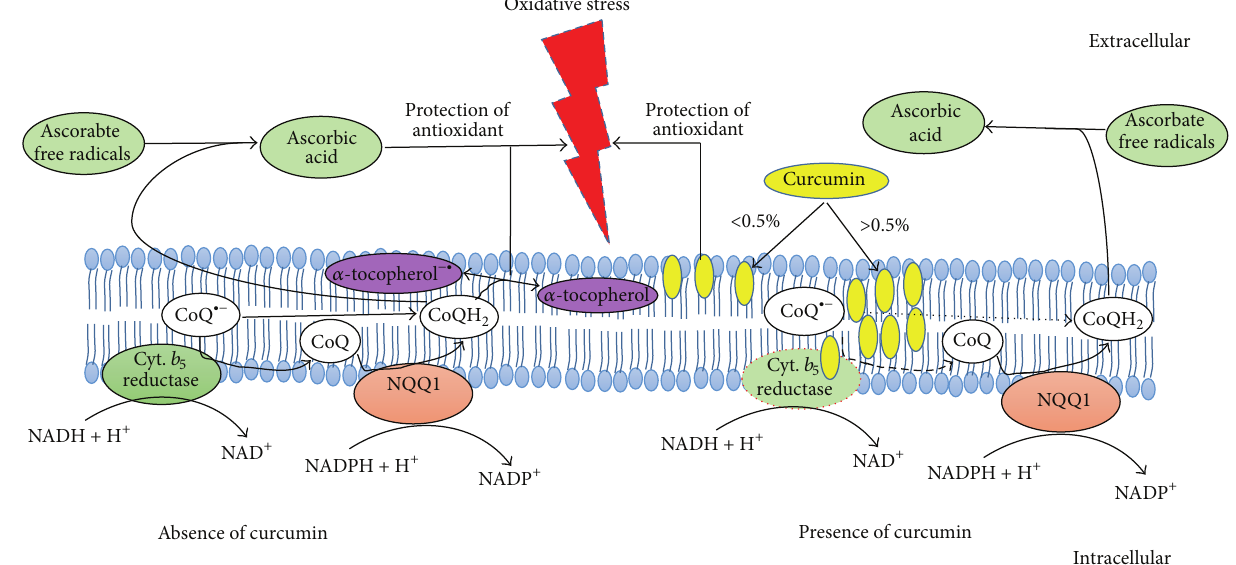
Figure 3: Proposed action mechanism of curcumin: dotted outline of PMRS component and arrow indicates the active targets of curcumin towards downregulation of the PMRS activity.